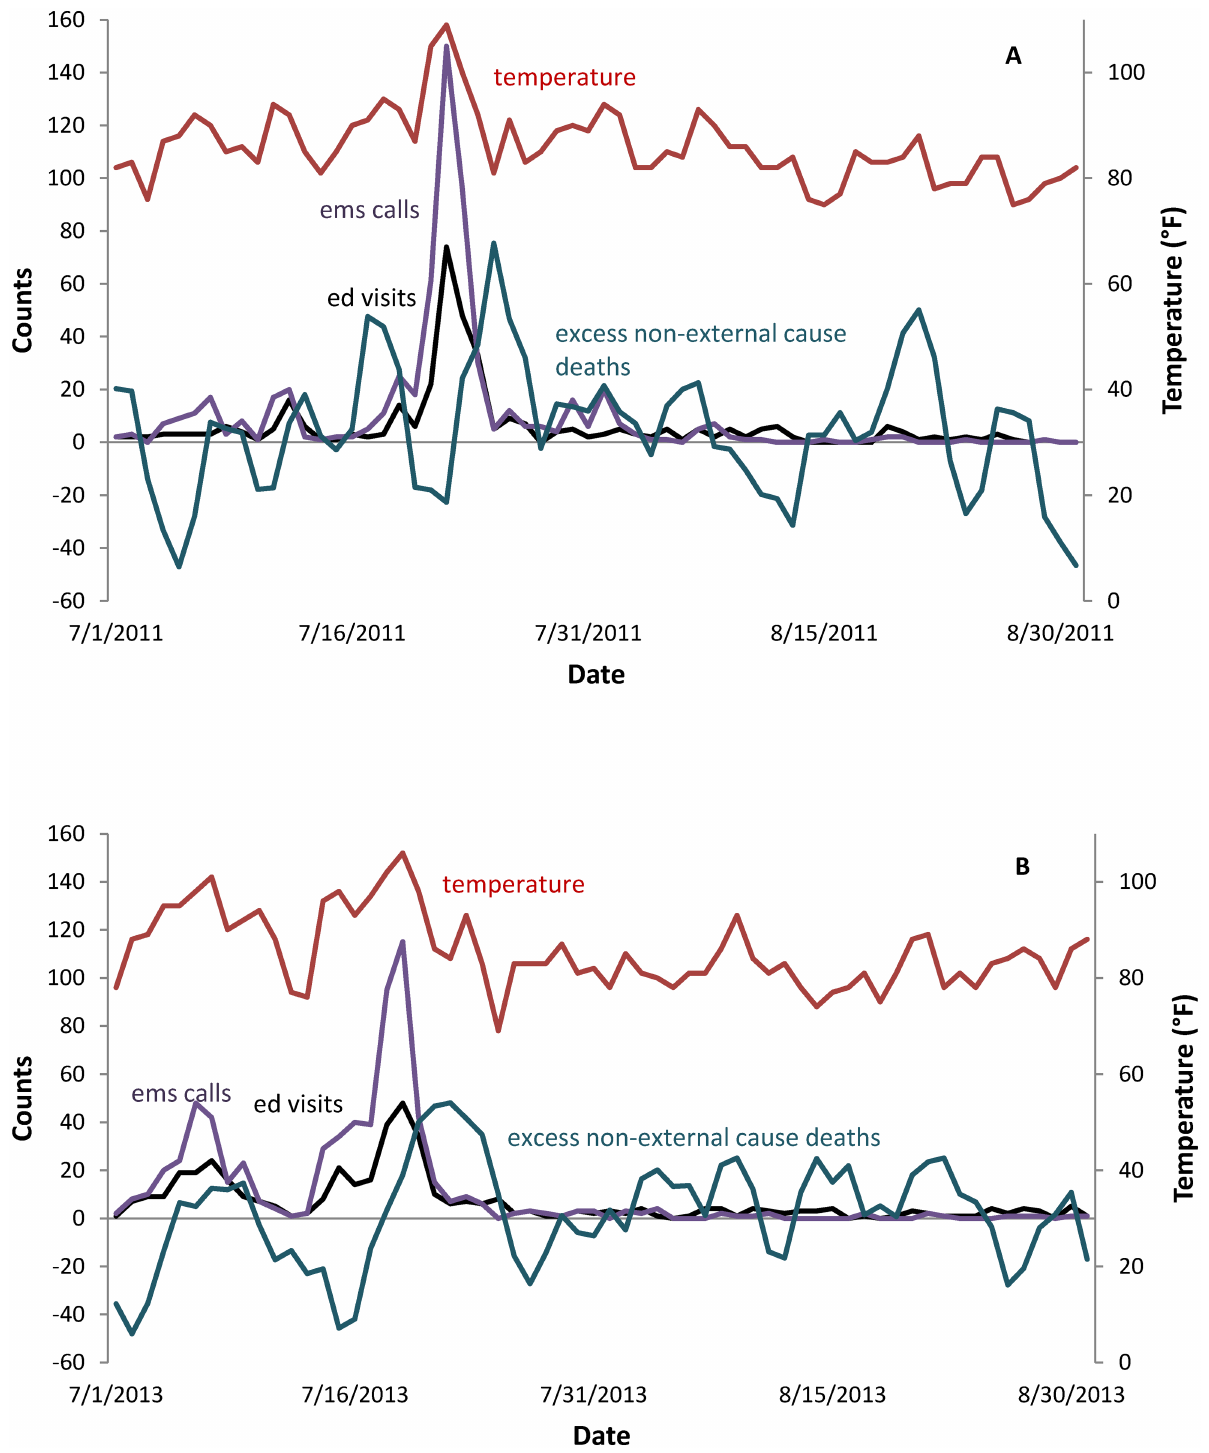
Fig 1. Time-series of daily heat-related EMS calls, ED visits, excessnon-external cause deaths, and maximum temperature or heat index. (A) July-August 2011. (B) July-August 2013.